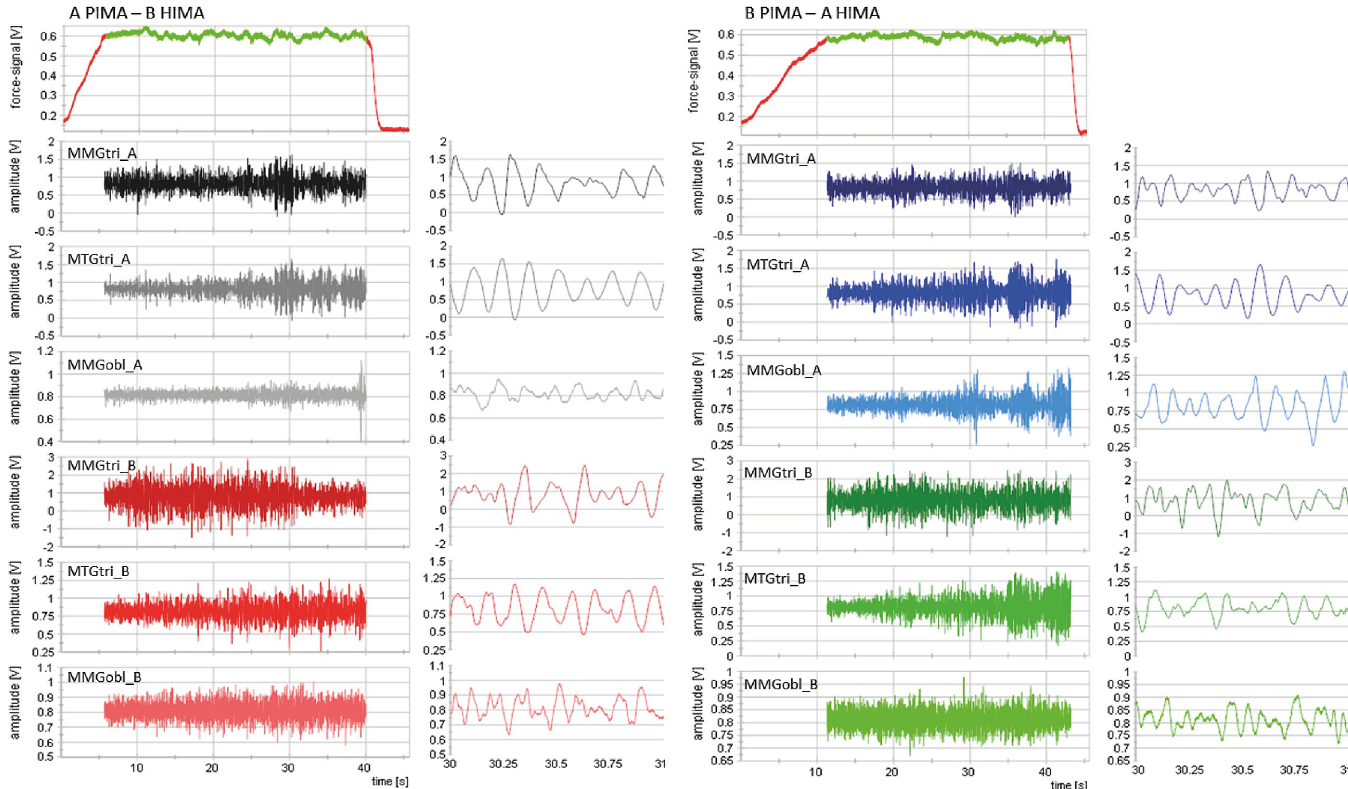
Fig 2. Exemplary raw signals. Displayed are the raw signals of two fatiguing measurements at 90% of the MVIC of one pair (A and B) of the strain gauge (V9 and the mechanomyo- and -tendographic signals (V) of the triceps brachii and the abdominal external oblique muscles and of the triceps tendon, respectively. Left diagrams: A PIMA, B HIMA; right diagrams: A HIMA, B PIMA. The 1s-intervals to the right of each diagrams of the whole duration illustrate the good signal quality of the oscillatory raw signals.